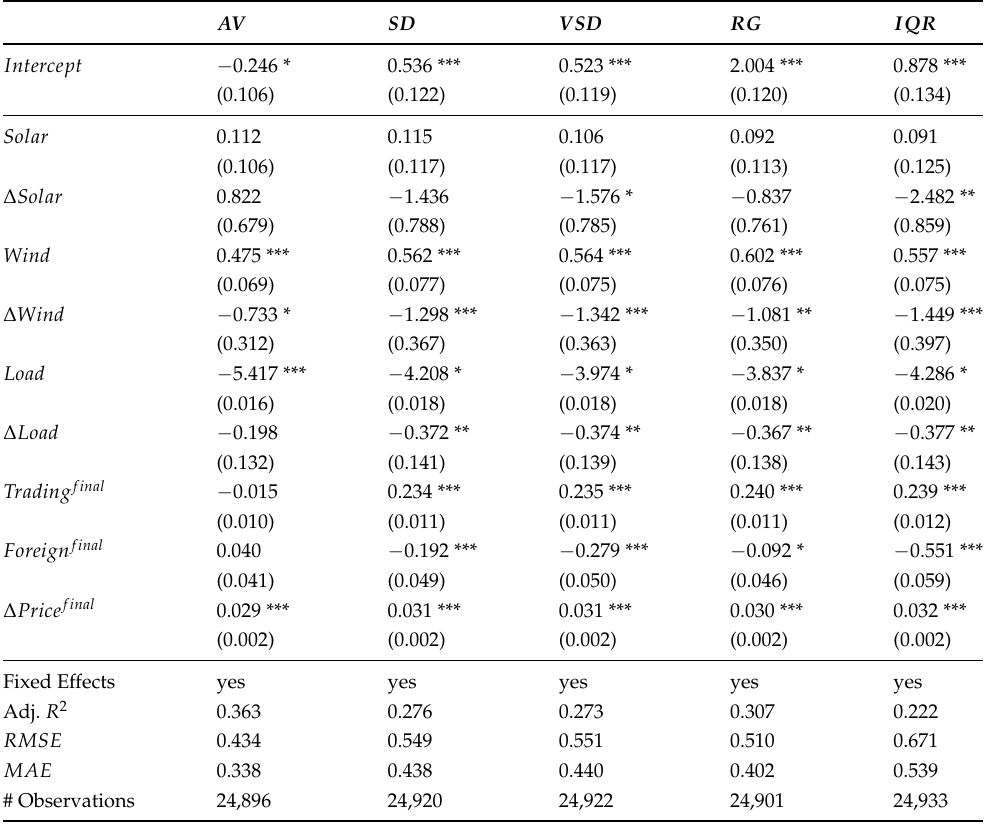
Table 7. Regression results for the five price fluctuations measures for the last trading hour. AV is the standard deviation of the price differences consecutive trades, SD is the standard deviation, VSD is the volume-weighted average standard deviation, RG is the range, and IQR is the interquartile range of all observable prices. Solar is the relative solar share of the total consumption, and ∆ Solar is the relative solar forecast error of the total consumption. Wind and ∆ Wind are analogously defined as the relative wind share and the relative wind forecast error of the total consumption. Load is the volume of the total consumption in TWh, ∆ Load is the unsigned relative excess generation over consumption in Germany, Trading is the traded volume of the intraday market in GWh, Foreign is the relative share of the volume (buy and sell) traded between Germany and a foreign country and the total traded volume of the intraday market, and ∆ Price is the absolute price difference of the day-ahead auction price and the volume-weighted average intraday price. RMSE is the root mean squared error, and MAE is the mean absolute error. The asterisks denote the significance level with *** = 0.1%, ** = 1%, and * =